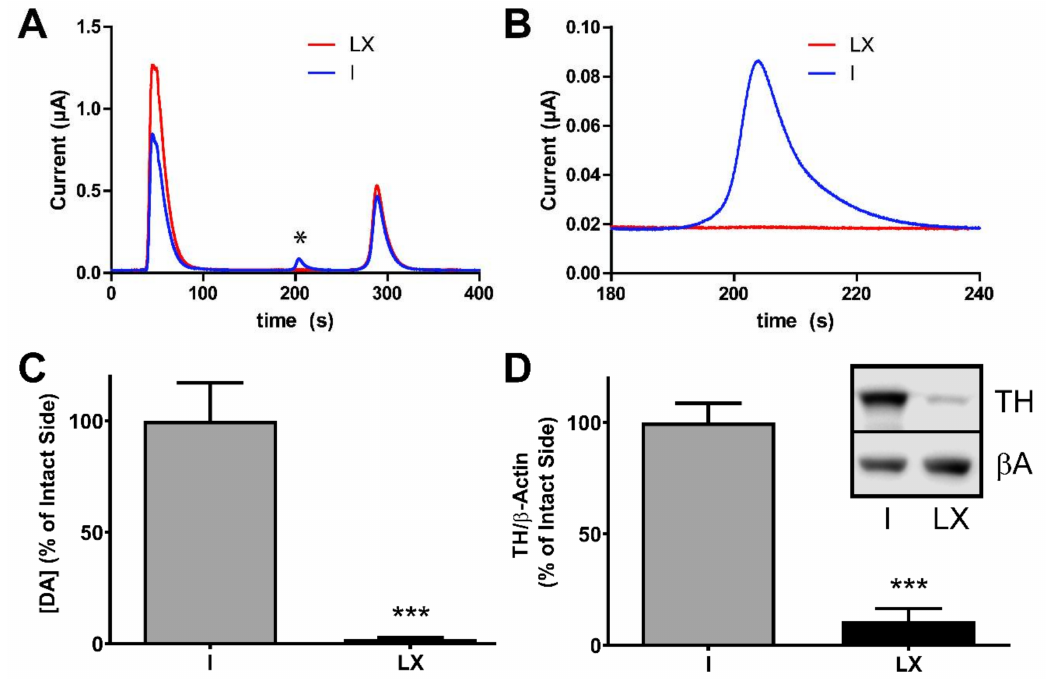
Figure 2. Verification of unilateral 6-OHDA lesion. ( A – C ) Electrochemical detection of striatal dopamine (DA) content. Representative separation of biogenic amines from tissue punches ( A ). The DA peak occurs around 200 s indicated by the *. The right panel ( B ) shows a zoom in of the DA peak. The peak area was integrated for analysis. The lesioned hemisphere (LX = lesioned) is in red, while the control hemisphere (I = intact) is in blue. ( C ) The DA content (mean ± SEM) is reduced by >95% in the lesioned side (*** p < 0.001, n = 10, two-tailed t -test). ( D ) Semi-quantitative Western analysis of striatal tyrosine hydroxylase (TH) expression. TH was normalized to β -actin ( β A) as internal standard, mean values ± SEM are plotted, and TH expression is reduced by ~90% in the lesioned side (*** p < 0.001, n = 10, two-tailed t -test) verifying the severity of the lesion. The inset shows representative example Western Blots (I = intact, LX =